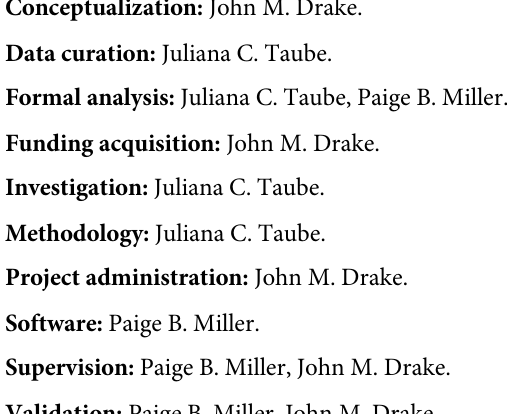
S1 Table. The mean proportion of nodes with complete attribute information when that attribute was listed as available for a given tree. Analysis was limited to 5 most common attributes in the database and trees with 20 or more cases and 2 or more generations of